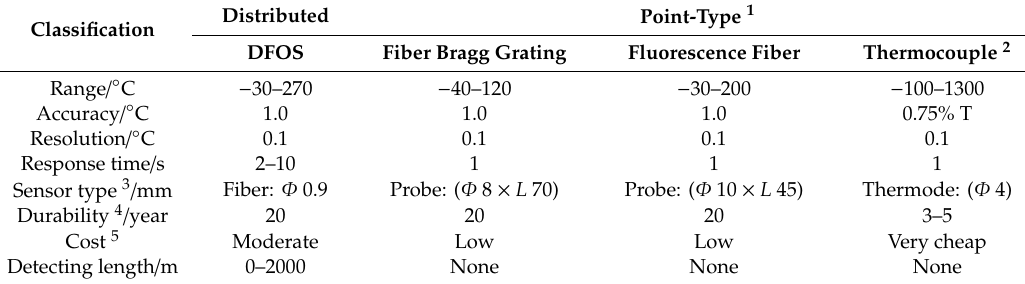
Table 2. Comparison between DFOS and other common temperature sensors for the